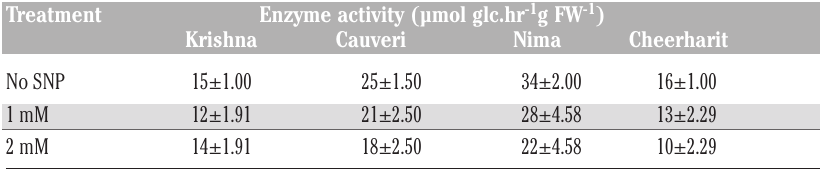
Table 3B. Effects of sodium nitroprusside (SNP) on alkaline invertase in Cymbopogon flex- uosus varieties Krishna, Cauveri, Nima and Cheerharit. A 15 d lemongrass tiller was